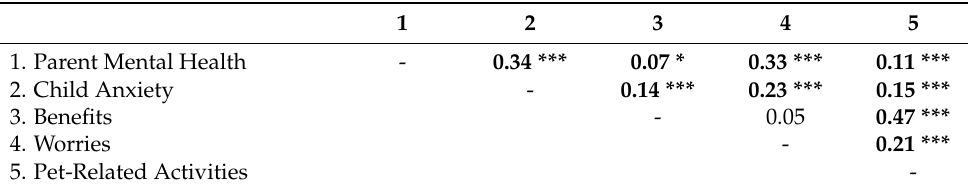
Table 2. Correlations between total scores for benefits, worries, activities, and parent and child mental health (all continuous variables, N = 1034).